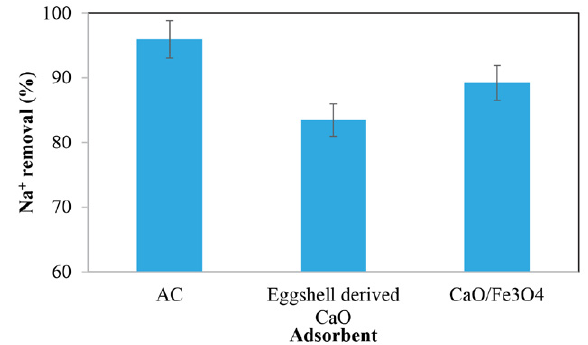
Figure 12. The removal efficiency of the adsorbents at optimal con- ditions (pH=11, time= 45 min, adsorbent dosage= 5 g/L, tempera- ture =25 °C and initial sodium concentration= 900